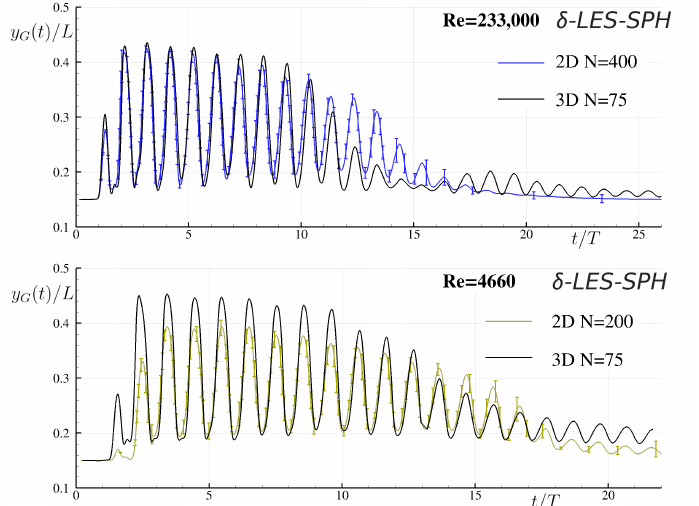
Figure 15. Time history of the vertical position of the fluid center of mass y G ( t ) evaluated by the SPH- Flow solver for the 2D and the 3D simulation. The 2D results are given by an ensemble average of ten simulations. Error bars refer to the computed standard deviation. ( Top ) water test-case. ( Bottom ) oil test-case.